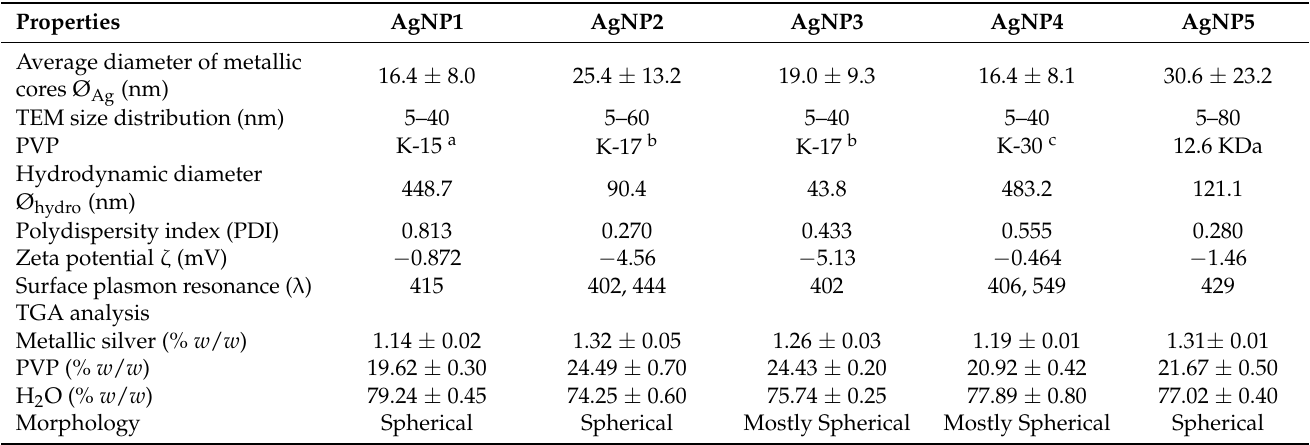
Table 1. Physicochemical properties for the five AgNP formulations studied in this